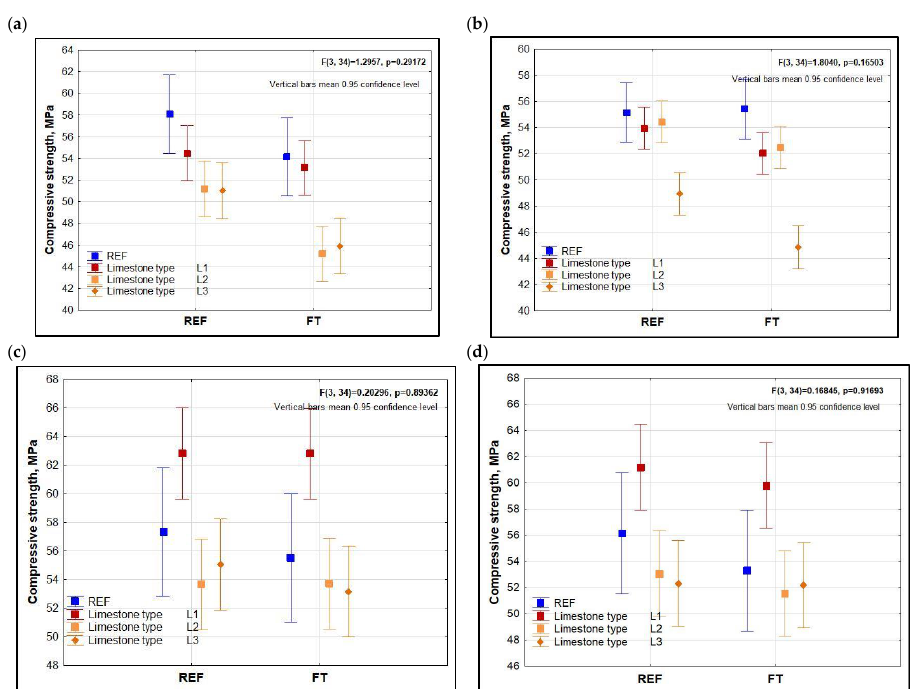
Figure 10. Strength loss for ( a ) vibrated concrete and ( b ) self-compacting concrete, both with air- entraining admixture.